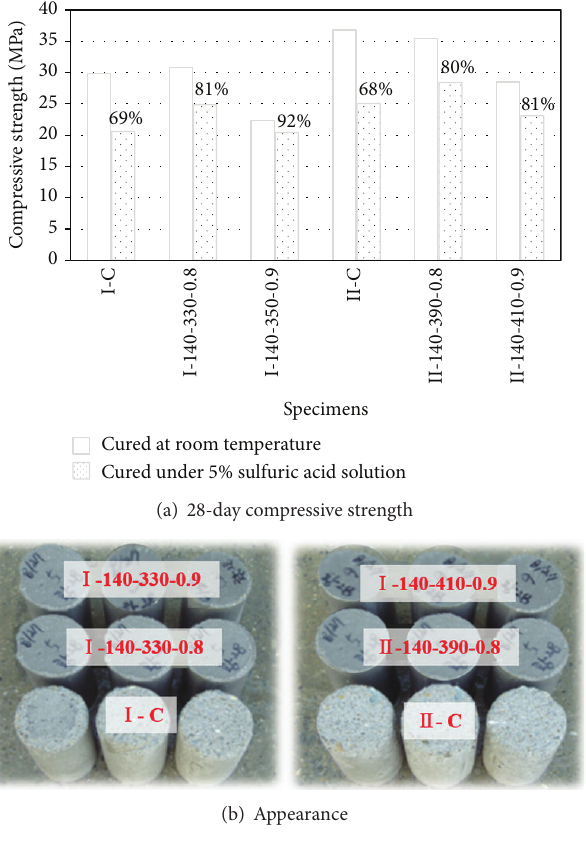
Figure 10: Variation of strength and appearance of concrete after saturation in sulfuric acid